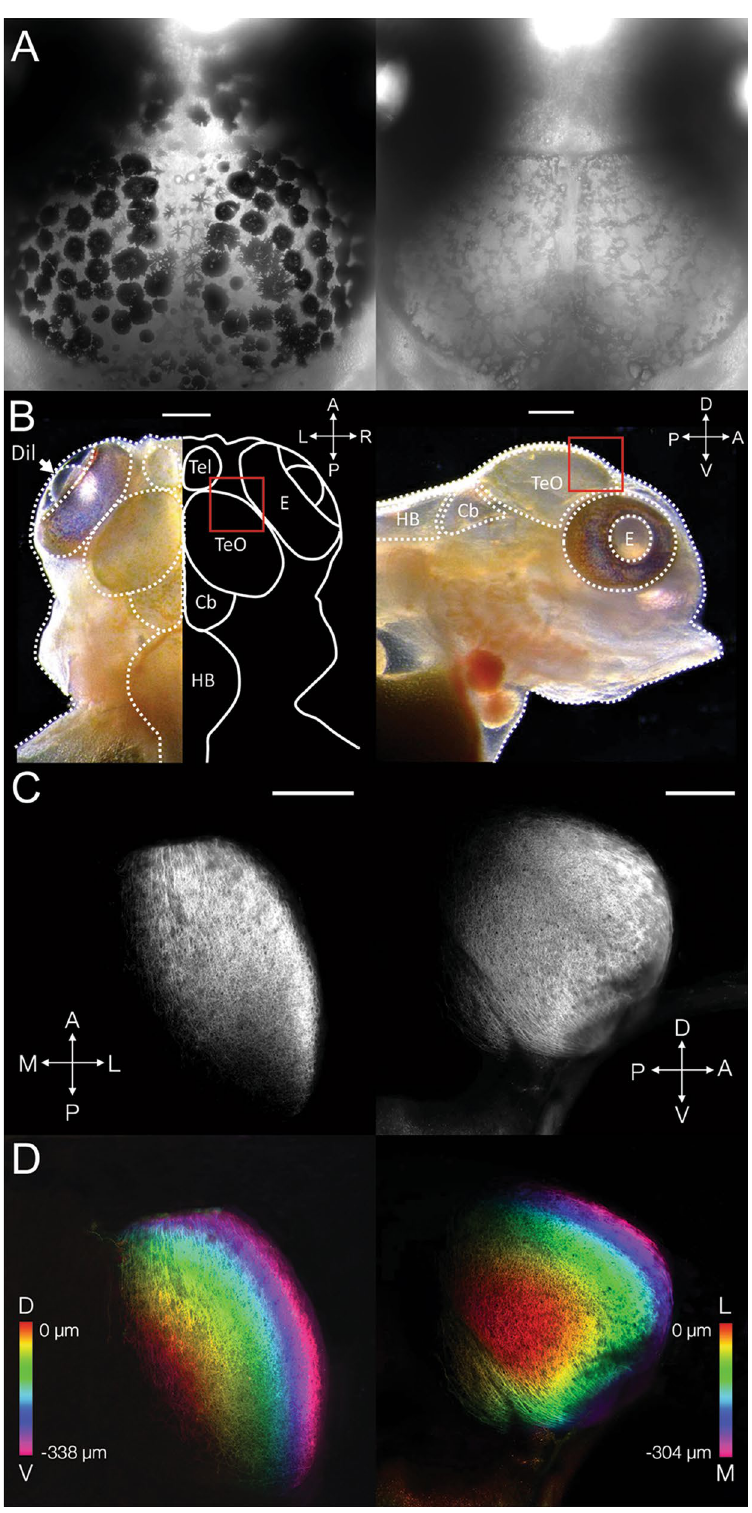
Figure 6. Tyrosinase mutant A. burtoni permit brain imaging in situ. ( A ) Dorsal view of the skin covering the midbrain in wild- type (left) and Tyr1 d20/d20 (right) fish at 9 dpf, imaged using transmitted light. Pigmented melanocytes are absent above the brain in Tyr1 d20/d20 fish, enabling underlying imaging of brain structures. ( B ) Dorsal view (left) and lateral view (right) of the head structure with schematic brain illustrations in Tyr1 d20/d20 larvae at 9 dpf. Note that in the DiI injection experiment, those images were focused on dorsal and lateral edges of optic tectum (regions in red squares). E eyes, Tel telencephalon, TeO coptic tectum, Cb cerebellum, HB hindbrain. ( C , D ) Contralateral retinotectal projections were visualized by confocal microscopy in 9 dpf Tyr1 d20/d20 cichlids after unilateral eye injection with DiI. Z-projections from dorsal (338 µm depth) ( C , D , left) and lateral (304 µm depth) aspects ( C , D , right) reveal retinal ganglion cell axons terminating throughout the peripheral optic tectum. Different colors depict the depth of brain tissues from the center surface (red) to the edge of the optic tectum (magenta). Scale bars 200